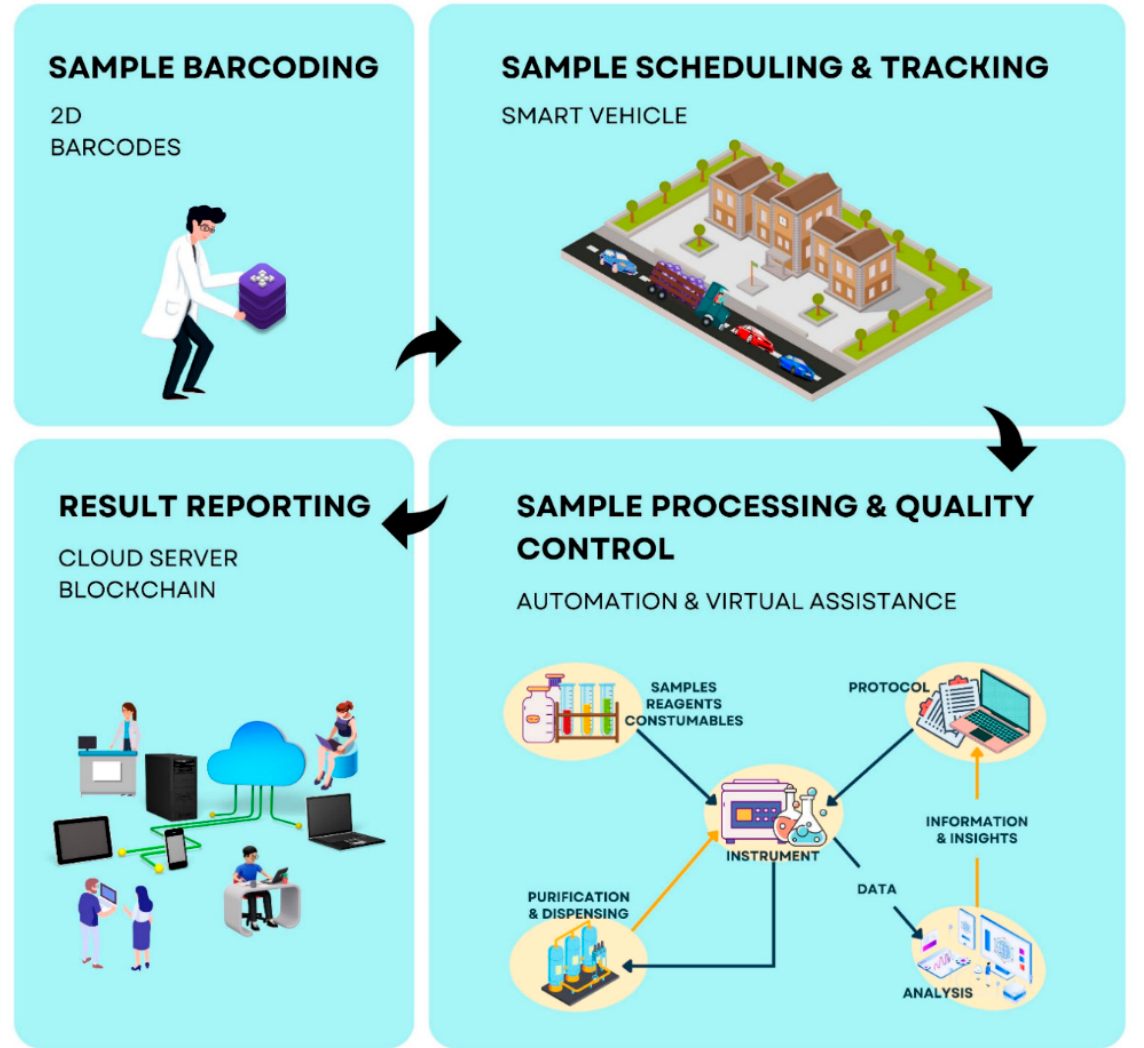
Figure 8. A depiction of a smart clinical laboratory supported by IoT.